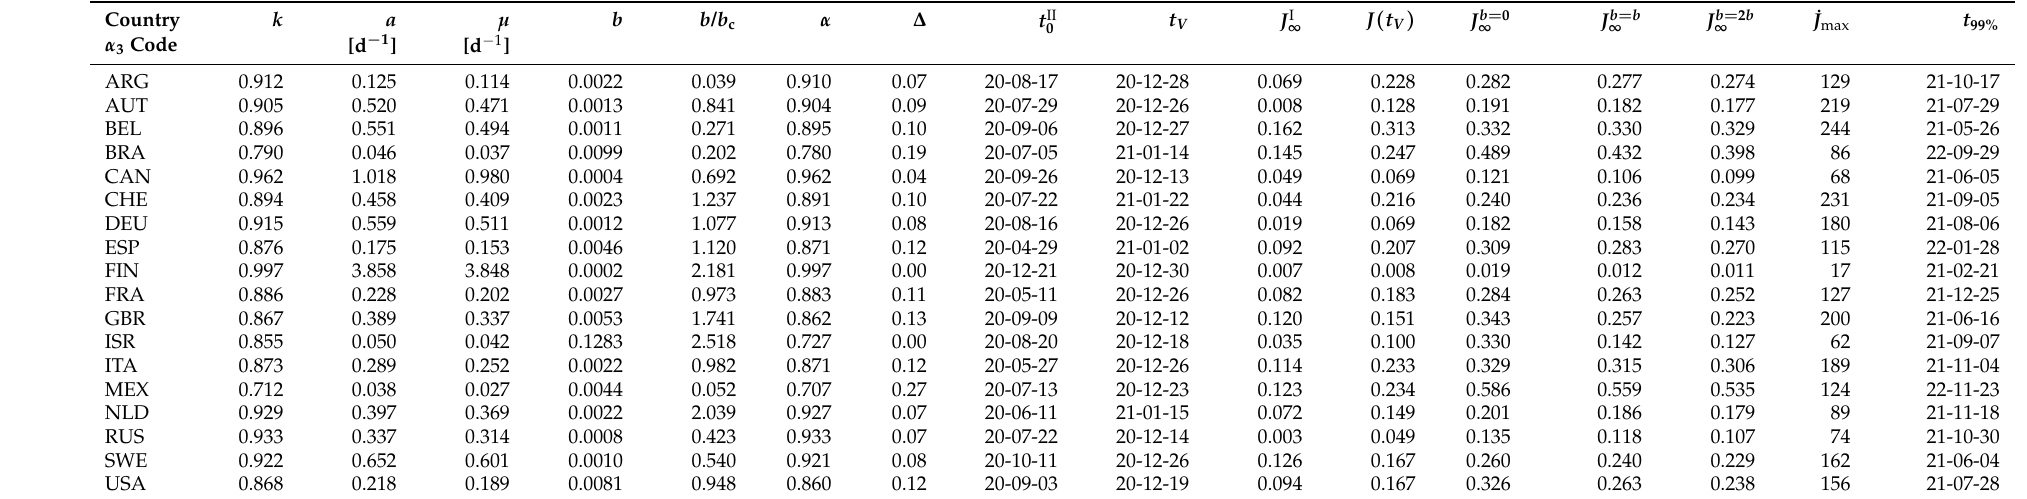
Table 1. Analysis using data from 18 March 2021. For η , k and a the current values for the second wave, that started at t II are used, all from the online resource [124]. The starting time, t V , 0 of the vaccination program and the mean daily fraction v of vaccinated population since then are retrieved from Ref. [123] assuming that each person has to be vaccinated twice and that the vaccination is effective two weeks after the second shot. The remaining quantities are derived from Equations (9) and (36), i.e., via µ = ak , b = v / a , α = k − b , and ∆ = 1 − 2 η − k − b is positive if the outburst condition (12) is fulfilled. b c is calculated via Equation (92). Furthermore, included are the infected population fraction at various times: (i) J I ∞ at the end of the first wave, J ∞ ( t V ) at the onset of vaccinations, (iii) J b = 0 ∞ assuming no vaccinations, (iv) J b = b ∞ assuming ongoing vaccination at the present rate, (v) J b = 2 b ∞ assuming the vaccination rate had been twice as large. The t 99% denotes the date at which 99% of the final J ∞ has been reached, and ˙ J max = j max a × 10 5 / N is the number of newly infected persons per 100,000 inhabitants within a single day, at peak time. The difference between J b = b ∞ and J b = 0 ∞ is the population fraction that profits from the current vaccination program. For all countries, η (cid:28) 1, k ∈ [ 0.7,1 ] , α ∈ [ 0.7,1 ] , b (cid:28) 1 hold. A daily updated and extended table containing more numbers such as η , v is part of our Supplementary